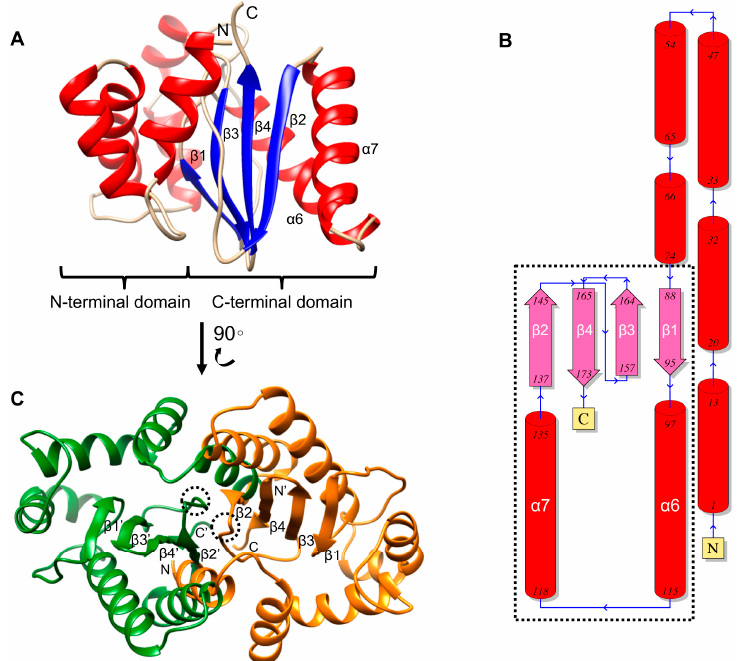
Figure 5. Structural characterization and homodimer. ( A ) The α -helices, β -strands and coils of the CsTegu20.6 are colored in red, blue and gold, respectively. N- and C-terminal domains are connected by a flexible linker, which is an intrinsically disordered region. The C-terminal domain constitutes a sandwich of a four-stranded antiparallel β -sheet, β 1- β 3- β 4- β 2, and two α -helices, α 6 and α 7; ( B ) Secondary structure topology diagram showing domain composition and connectivity. The ribbon diagram indicates α -helices and β -strands in red and magenta color, respectively. The diagrams associated with the ferredoxin fold are indicated with a dotted rectangle; ( C ) The homodimer with symmetry-related CsTegu20.6 monomers ( green and orange ) was constructed by GalaxyGemini [44]. The missed fifth β -strand is indicated with dotted circles [45] (see Section 2.6).